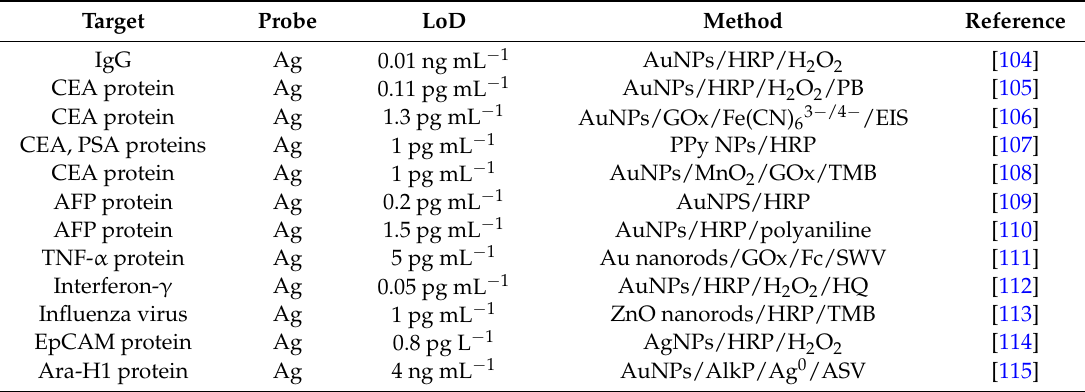
Figures of merit of selected enzymatic immunosensors using metal or metal oxide